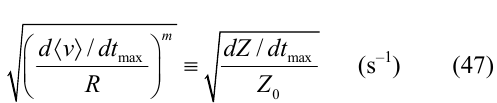
Fig. 8. ECG, ultra-low frequency ballistocardiogram (BCg), dZ/dt, and ∆Z(t) from a human. Note that the “I” wave of the HJ interval peaks precisely with dZ/dt max . The unlabeled noisy signal above ECG is a phonocardiogram. From reference